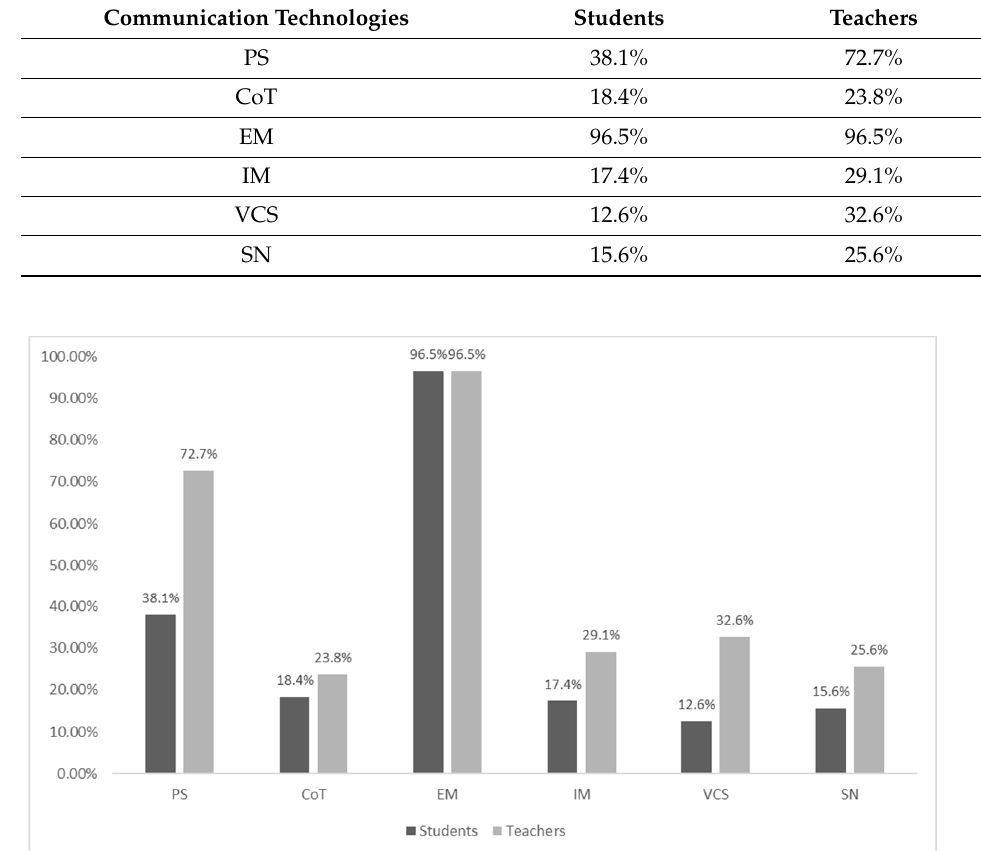
Figure 2. Communication technologies used by students and teachers.